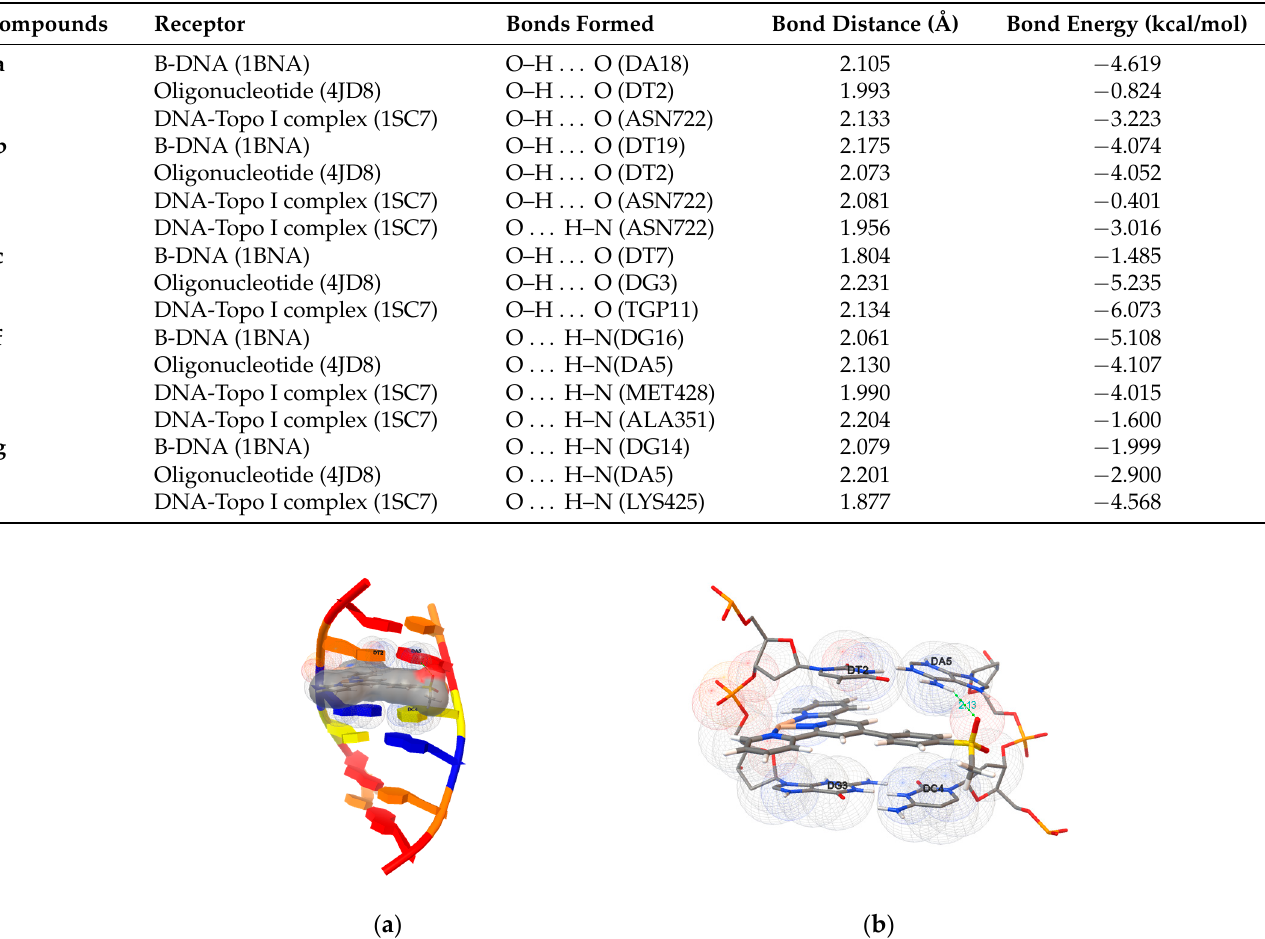
Table 3. Hydrogen bond interactions for compounds 2a – 2c , 2f and 2g .